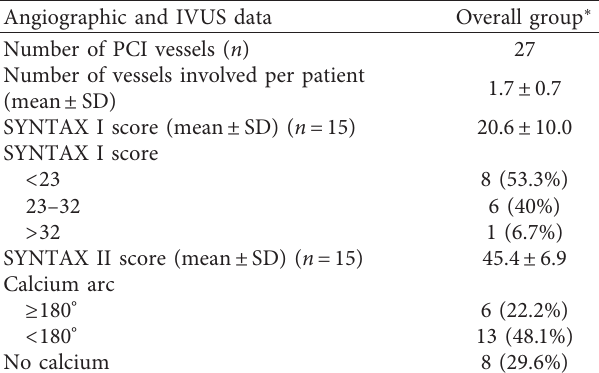
Table 2: Angiographic and IVUS